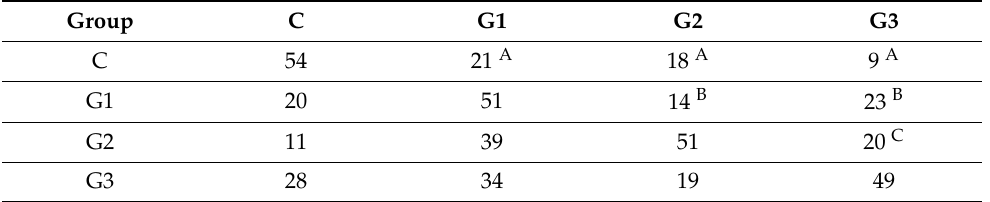
Table 4. The numbers of mRNAs that were differentially expressed in the whole blood samples from patients with endometrial cancer compared to a control.